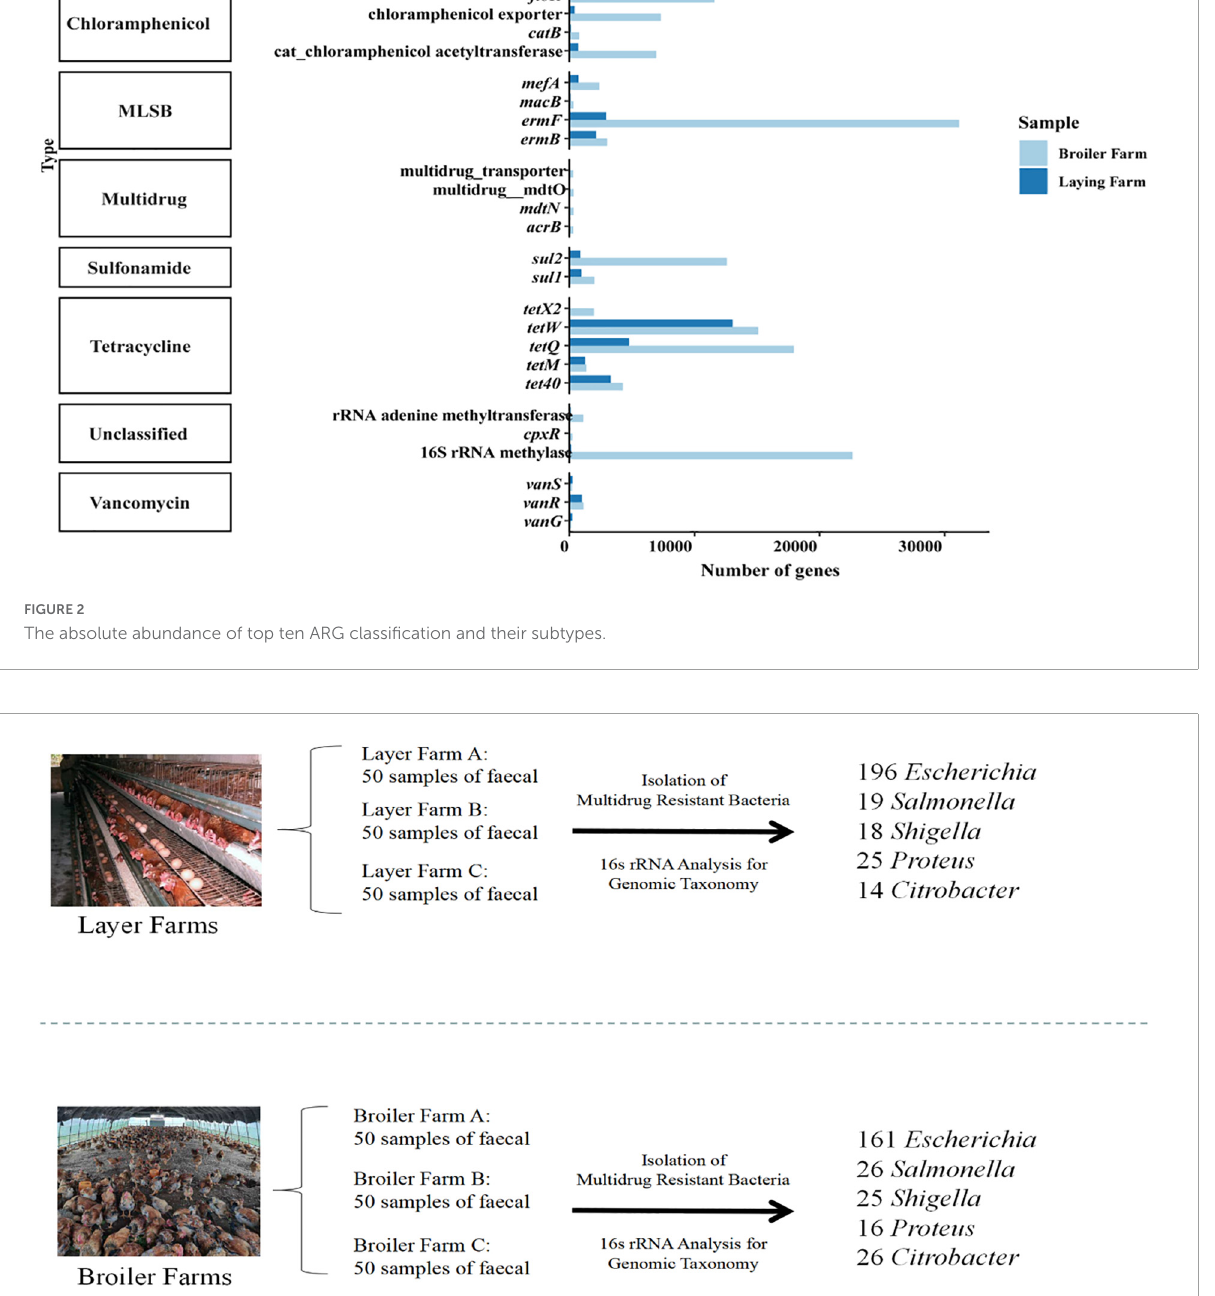
FIGURE3 Collection and isolation of MDR